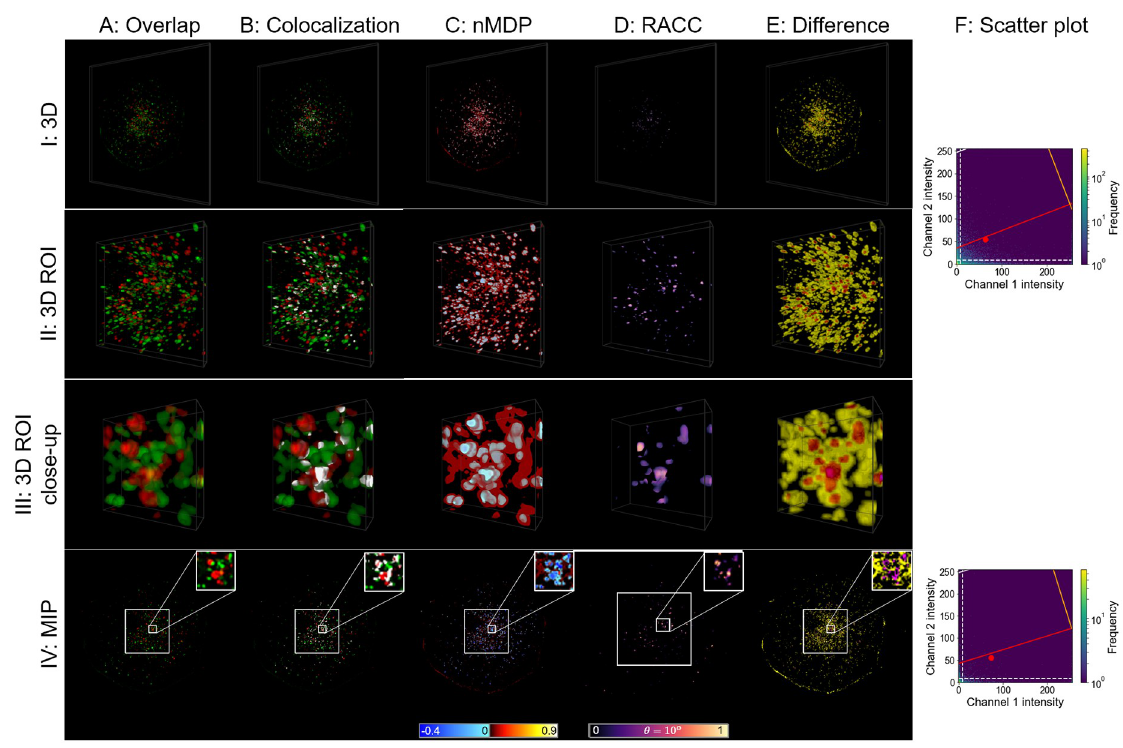
Fig 7. Autophagasome (green) and lysosome (red) fusion visualisation. The structure of the figure is similar to that of Fig 5, but in this case biological samples and not synthetic data are considered.